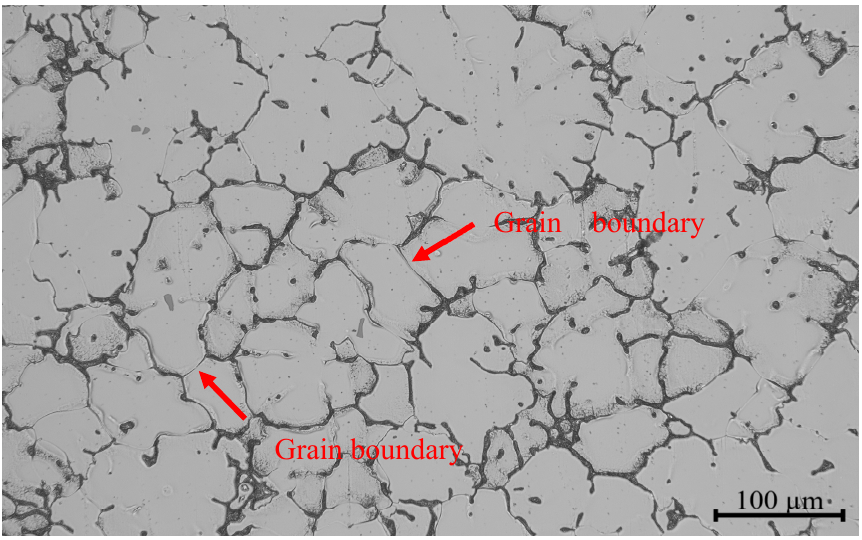
Figure 3. Optical micrograph of squeeze-cast ZL205A.